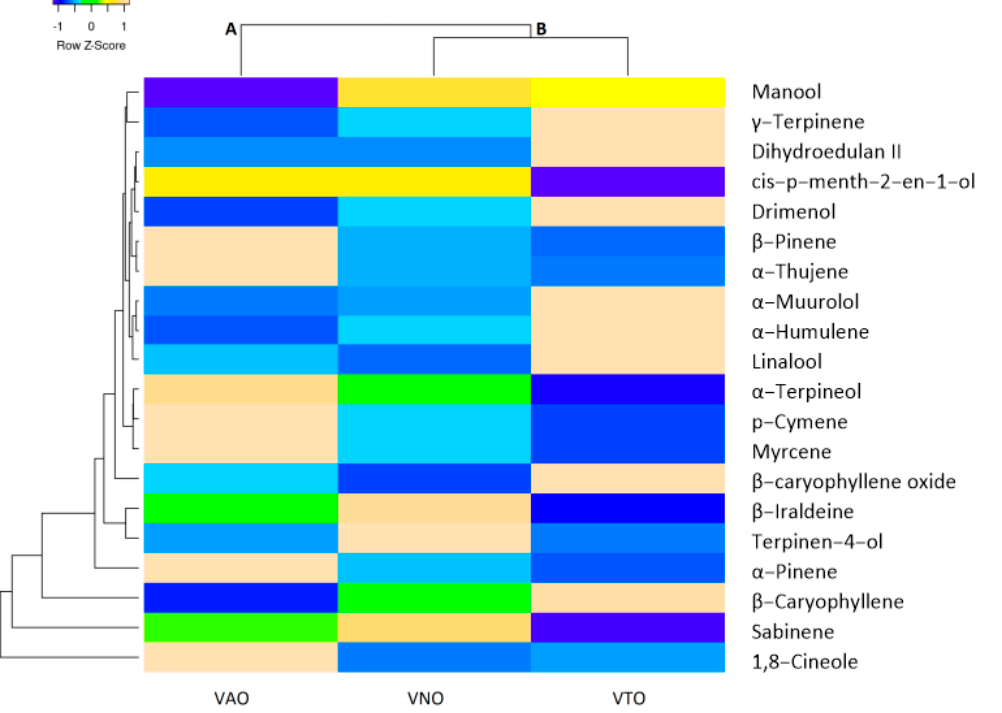
Figure 1. The heatmap analysis of the common essential oil constituents and tested species (The distribution of trait (common essential oil components) was identified by colors, where yellow color showed the maximum value of the trait, and blue color represented the minimum value).